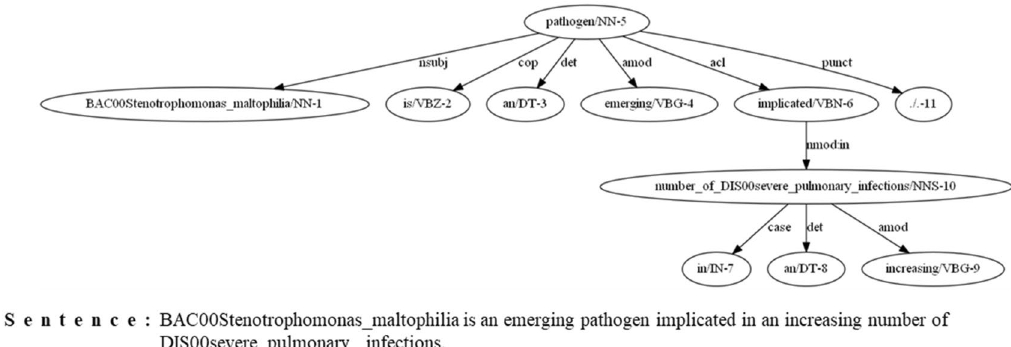
Figure 4. An example of microbe-disease relation extracted from a dependency tree. Two entity nodes, ‘BAC00Strenotrophomonas_maltophilia’ and ‘DIS00severe_pulmonary_infections’, have a lowest common ancestor of ‘pathogen’, which has a more descriptive child node of ’implicated’ without a descriptive child node. Therefore, ’implicated’ is extracted as the relation word between two entities of microbe and disease.